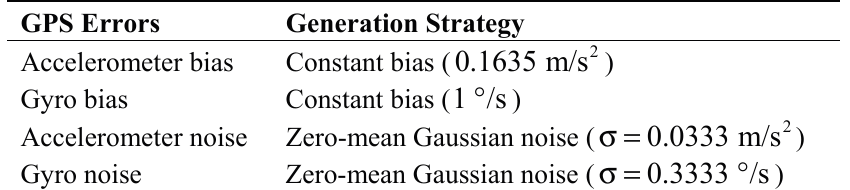
Table 2. IMU simulation generation method.